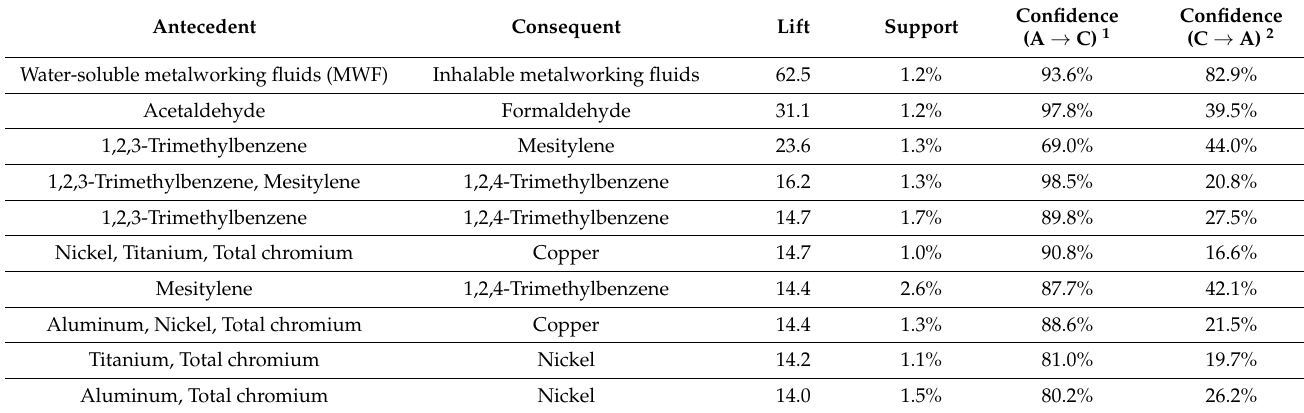
Table 5. List of the ten rules with the highest lift (minimum support of